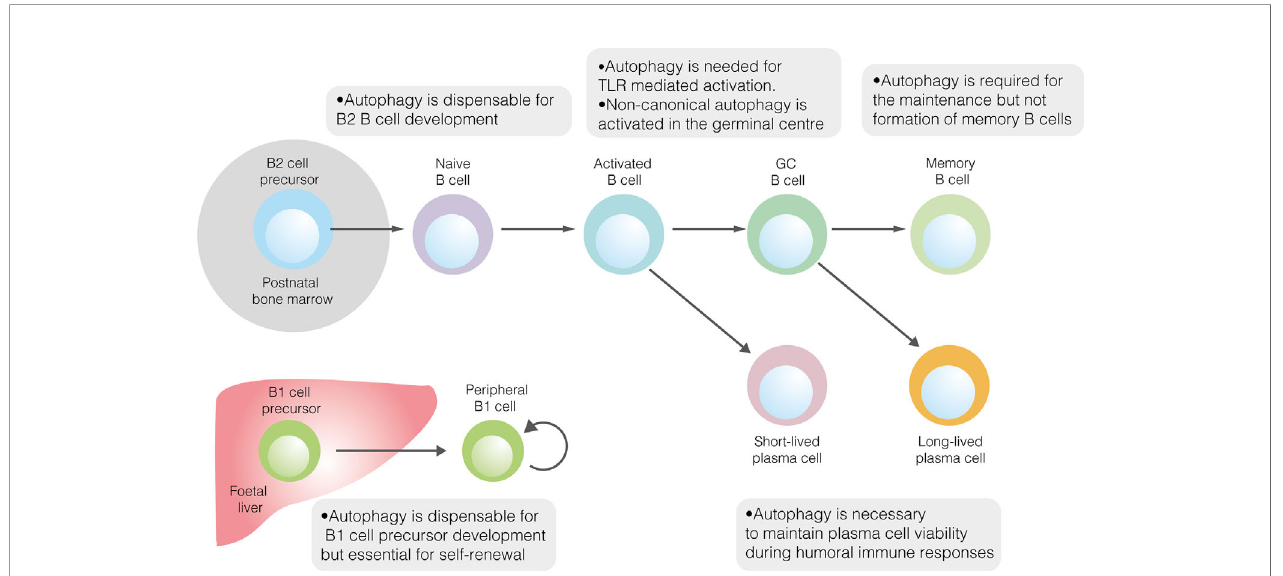
FIGURE 1 | The role of autophagy in developmental and mature B cells. Autophagy performs homeostatic roles in various B cell subsets. It is dispensable for the development of both B1 and B2 cells but is required for the peripheral self – renewal of B1 cells. Regarding B2 cells, autophagy is necessary for TLR – mediated, but not antigen – driven, activation. Autophagy also plays important roles in sustaining plasma cell immunoglobulin production and ensuring memory B cell